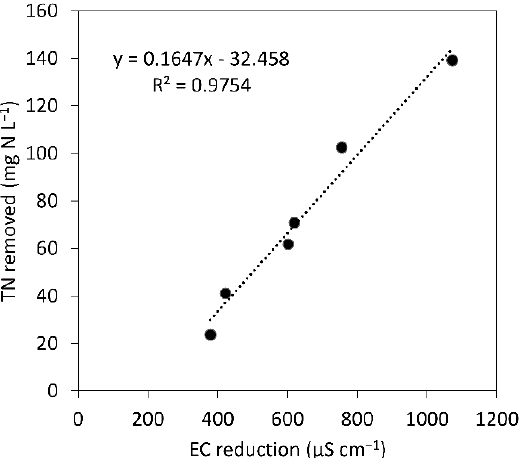
Figure 8. Linear correlation between the amounts of TN removed and the corresponding reduction of EC recorded at the same period in all experiments.